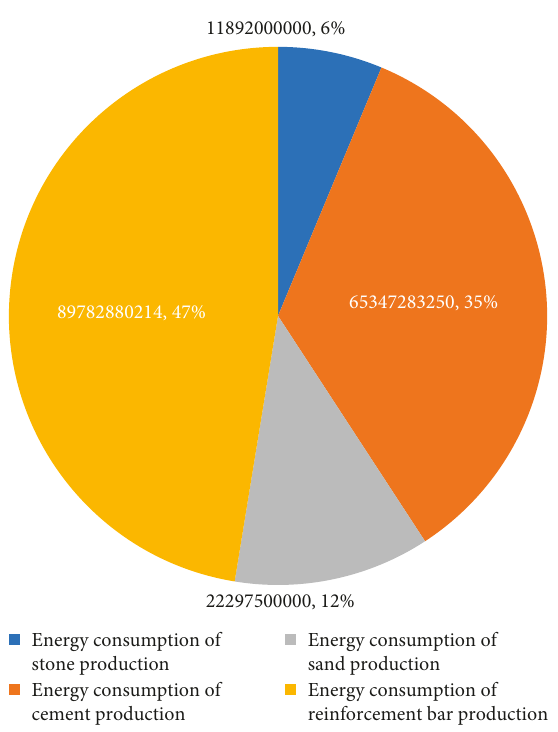
Figure 11: Energy consumption for raw material production of prefabricated columns.